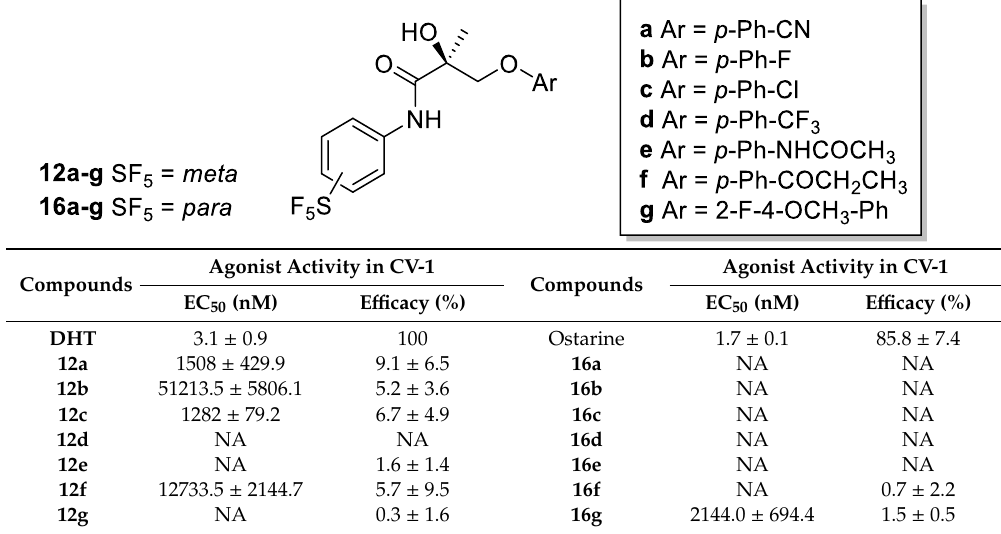
Table 2. AR agonist activity of aryl propionamide derivatives.